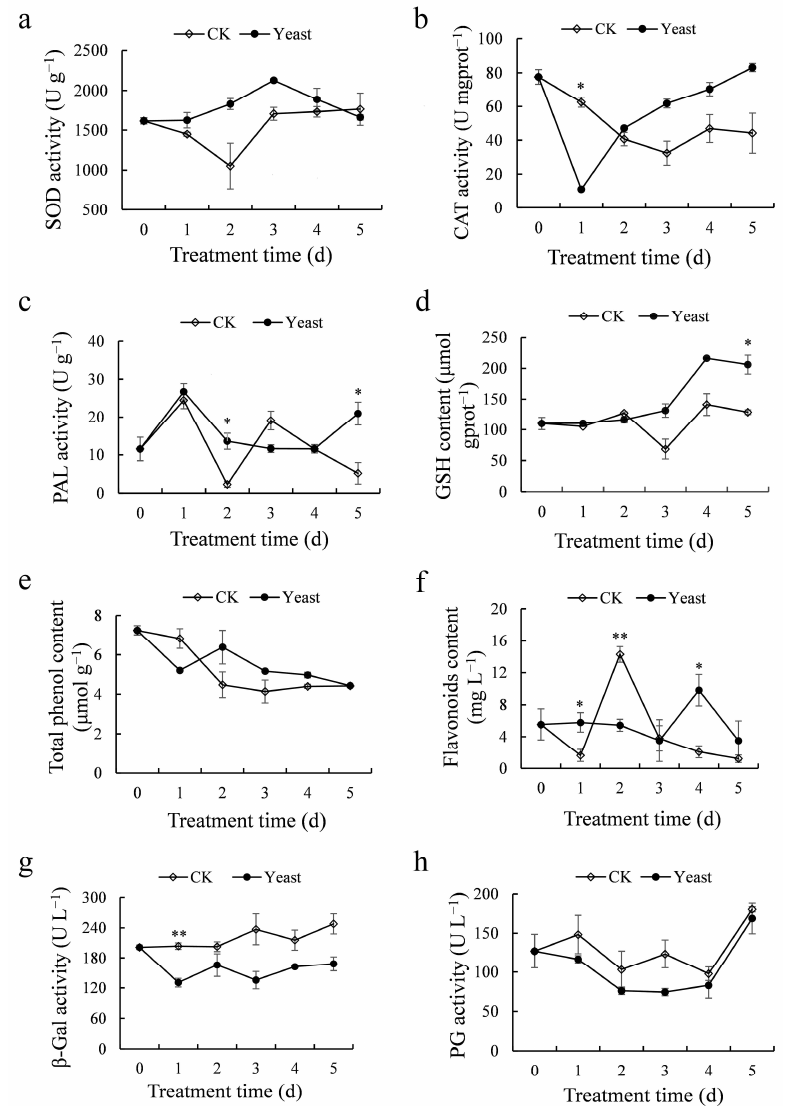
Figure 7. Effect of M. guilliermondii 37 on enzyme activity and antioxidant content in kiwifruit inoculated with B. dothidea for 5 days at 25 ◦ C. ( a – h ) show changes in SOD, CAT, PAL, GSH, total phenol and flavonoids content, β -Gal, and PG, respectively. The data is represented as mean ± SE. * indicates the significant level of differences between treatments evaluated by Student’s t -test at p < 0.05, ** indicates the significance level of the differences at p < 0.01.